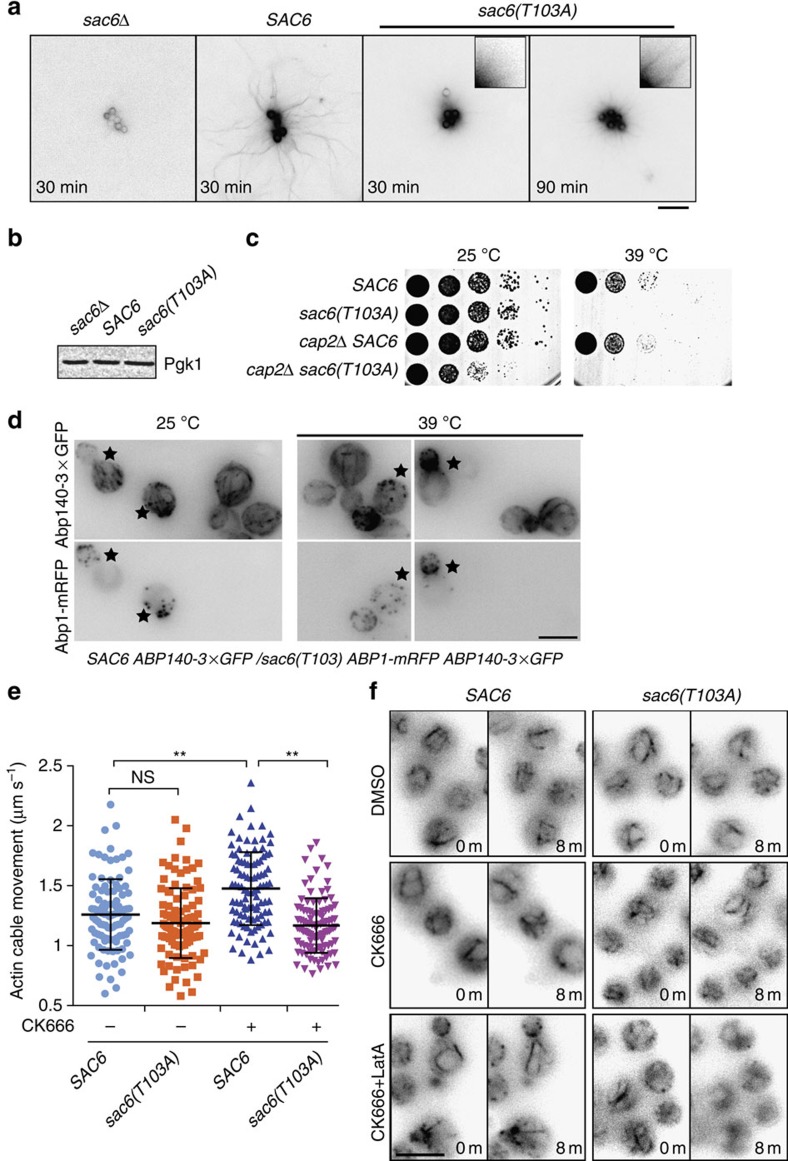
Sac6 phosphorylation regulates actin cable dynamics and is important for normal cell growth.(a) GST-Bni1 FH1-COOH-functionalized beads were added to cytoplasmic extracts from hydroxyurea (HU)-arrested yeast cells of indicated genotypes expressing Abp140-3 × GFP. (b) Protein concentration for cytoplasmic extracts used for actin reconstitution in a is compared using Pgk1 by immunoblotting. (c) Growth test by serial dilution of WT, cap2Δ, sac6Δ, cap2Δ SAC6, cap2Δ sac6(T103A) double mutant on YPD plates. Plates were incubated at indicated temperature for 24 h. (d) Fluorescent pattern of actin filaments in SAC6 and sac6(T103A) showed by maximum intensity Z-projection. Cells were grown at 39 °C for 30 min before imaging. Star indicates sac6(T103A). (e) Actin cable movement speed in HU-arrested cells treated with or without CK666 (n=100). A concentration of 50 μM CK666 treatment was applied for 30 min at room temperature. Actin filament elongation rate was measured by monitoring the ends of the elongating cables. (f) Depolymerization of actin cables by Lat A treatment. Real-time imaging of actin cables at the cell cortex in SAC6 and sac6(T103A) cells. Cells were pretreated with 50 μM CK666 or DMSO for 30 min at room temperature before adding 0.4 μM Lat A. Images were acquired at 2-min intervals after adding Lat A. Images at time point 0 and 8 min are shown. Scale bars, 5 μm. Error bars are in s.d. One-way analysis of variance was used. **P<0.0001. DMSO, dimethylsulphoxide; NS, not significant.